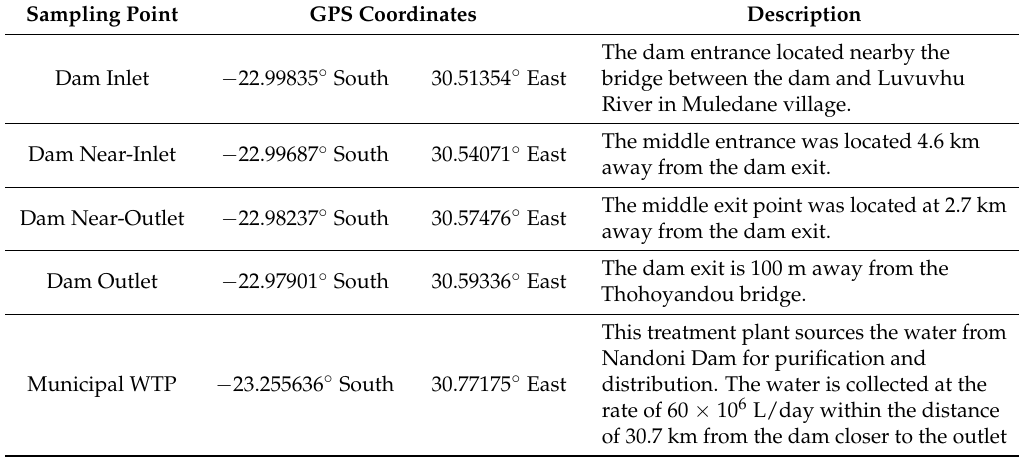
Table 1. The geographical location of the sampling points (the dam and treatment plant water